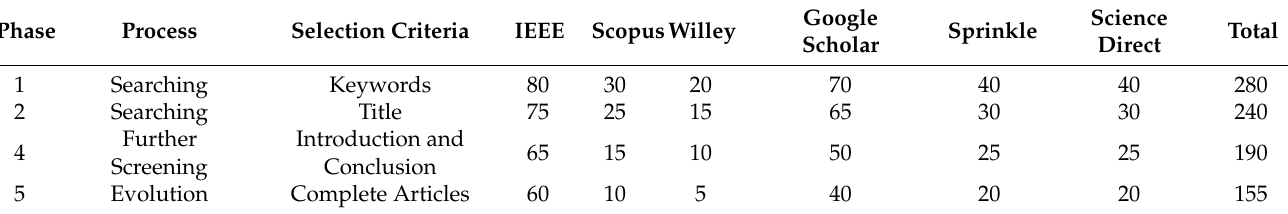
Table 4. Research query process.